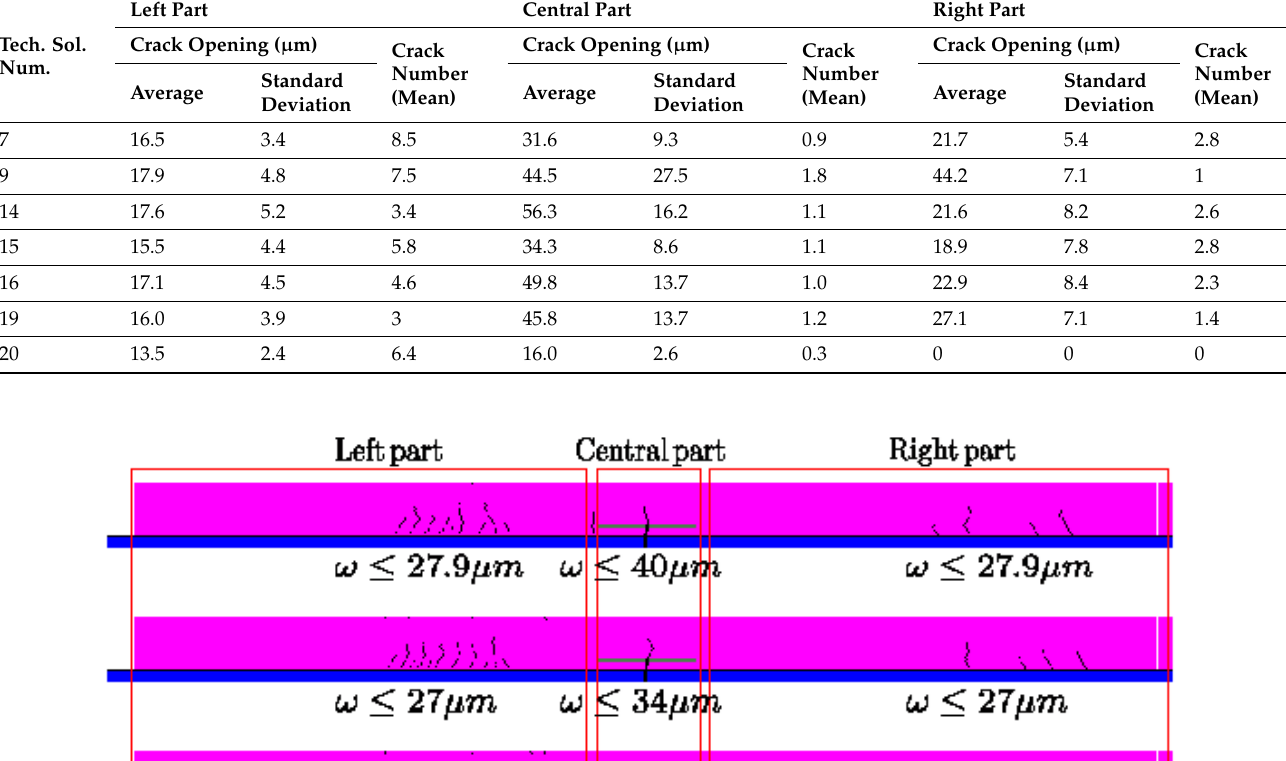
Table 3. CO 2 emissions per slab’s